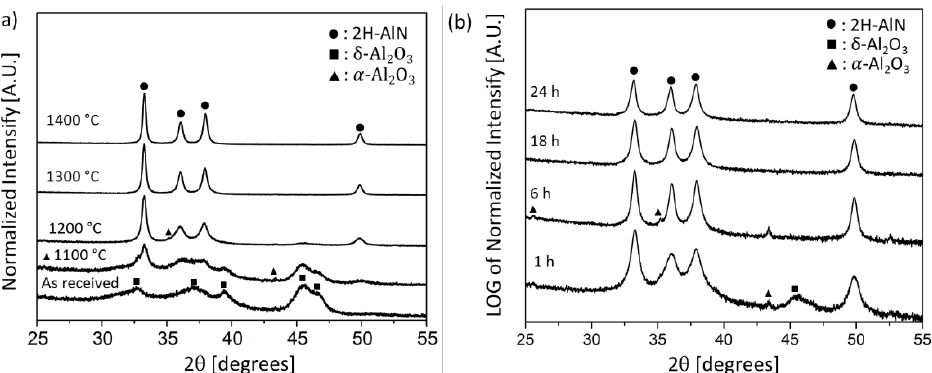
Figure 1. The effect of nitridation time and temperature on phase evolution of powders ( a ) XRD patterns of samples at various times. ( b ) XRD patterns of samples at 1200 ° C for various times. Normalized intensity is plotted with in log scale to emphasize minor phases.